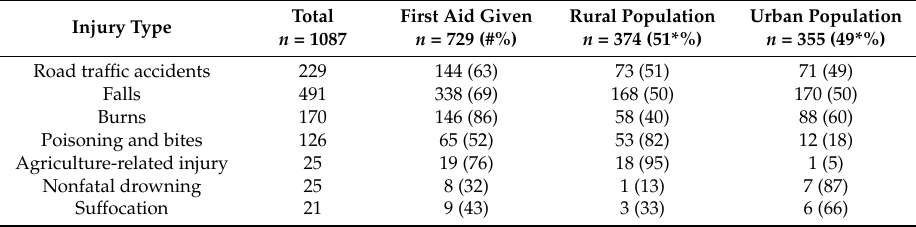
#% Column percentage, *% Row percentage.